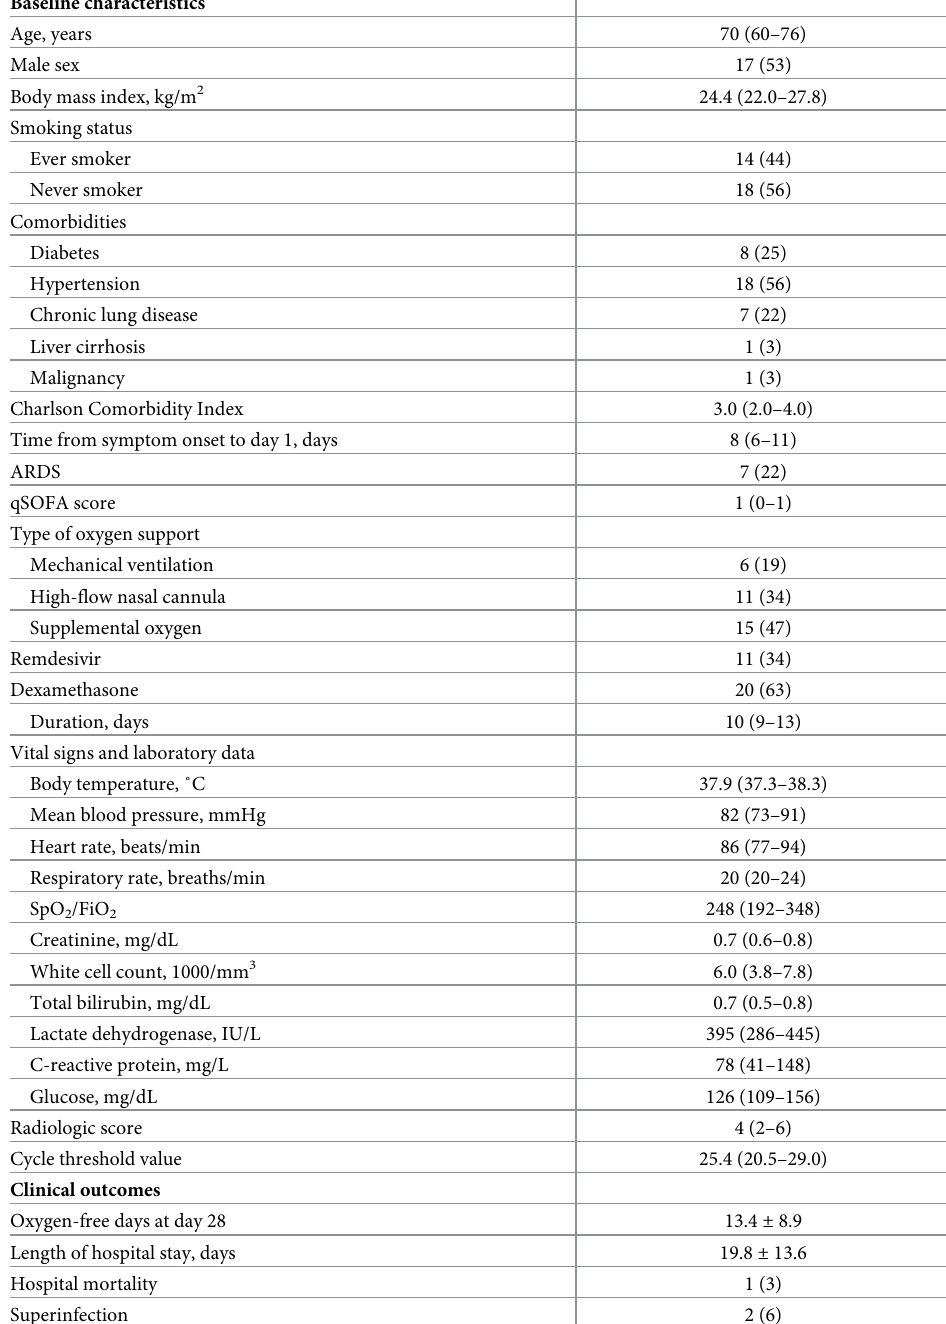
Table 1. Baseline characteristics and clinical outcomes of the 32 patients with severe